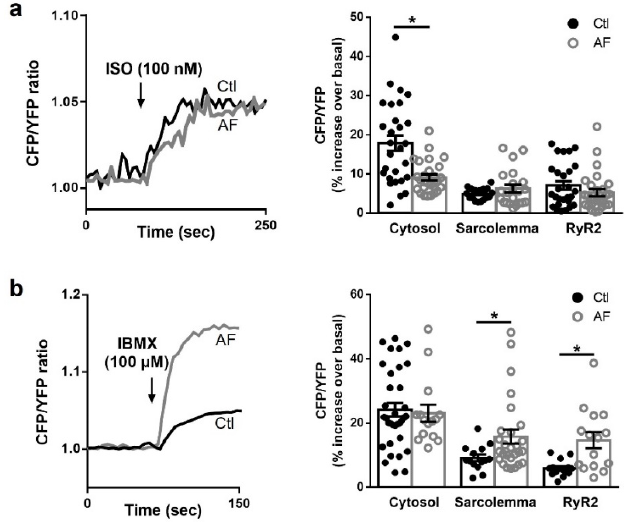
Figure 4. Cytosolic and local cAMP dynamics. ( left ): representative kinetics of fluorescence reso- nance energy transfer (FRET) changes (expressed as CFP/YFP ratio) in the ryanodine receptor (RyR2) microdomain recorded in human atrial myocytes from patients in sinus rhythm (Ctl) and with atrial fibrillation (AF), transduced with Epac1-camps-JNC sensor and treated with ( a ) isoproterenol (ISO, 100 nM) and ( b ) the non-selective phosphodiesterase inhibitor (IBMX, 100 μ M) and the phosphodiesterase type 8 selective inhibitor PF-04957325 (100 nM). ( right ): average increases in cAMP levels in the cytosol and in different compartments (sarcolemma and RyR2) of living human atrial myocytes, measured as total cAMP produced after exposure ( a ) to ISO and ( b ) to the inhibitor IBMX. Significant differences between treatments are indicated with